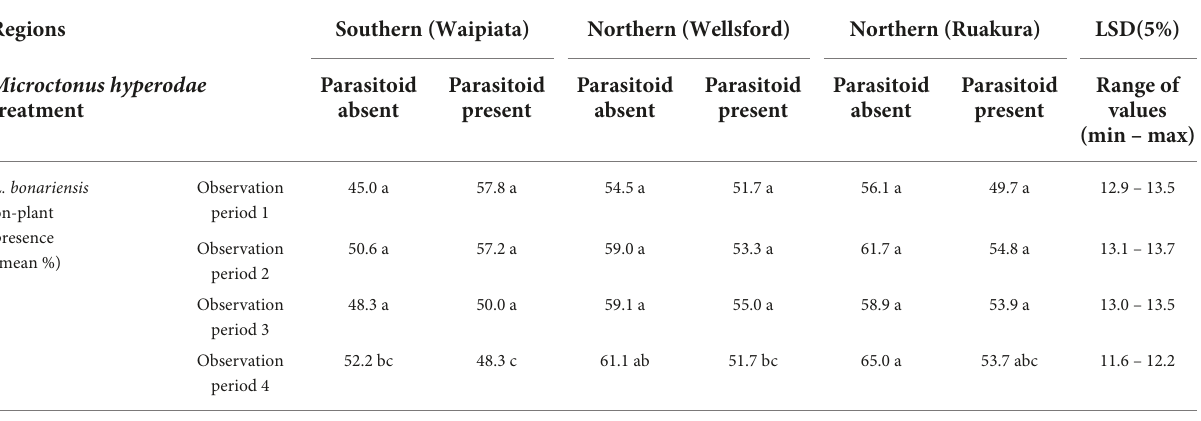
TABLE 3 Behavioural experiment 2.